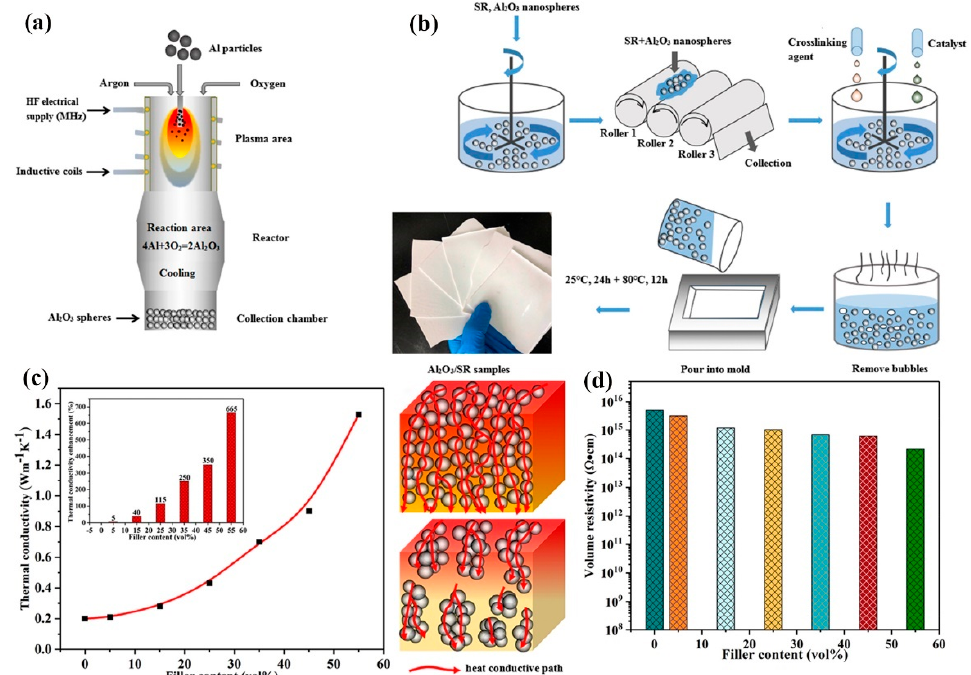
Figure 16. ( a ) Schematic diagram for the preparation process of Al 2 O 3 nanospheres by thermal plasma and ( b ) Al 2 O 3 /SR composites. ( c ) λ of Al 2 O 3 /SR composites and heat flow models. ( d ) Volume resistivity of the Al 2 O 3 /SR composites (reproduced with permission from [79]).